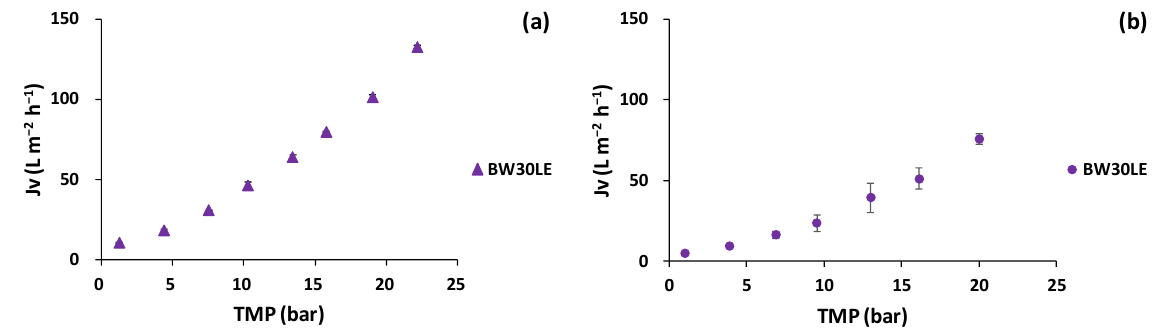
Figure 6. Trans-membrane flux variation as a function of the trans-membrane pressure for BW20LE RO membrane for ( a ) lees filters and ( b ) olive pomace extracts.